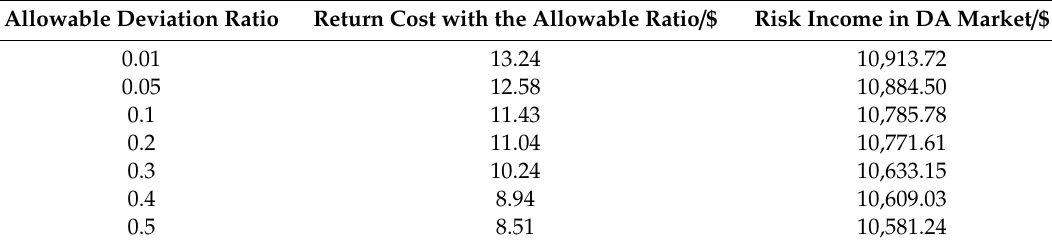
Table 2. Risk income of DA market with di ff erent allowable deviation ratios. Allowable Deviation